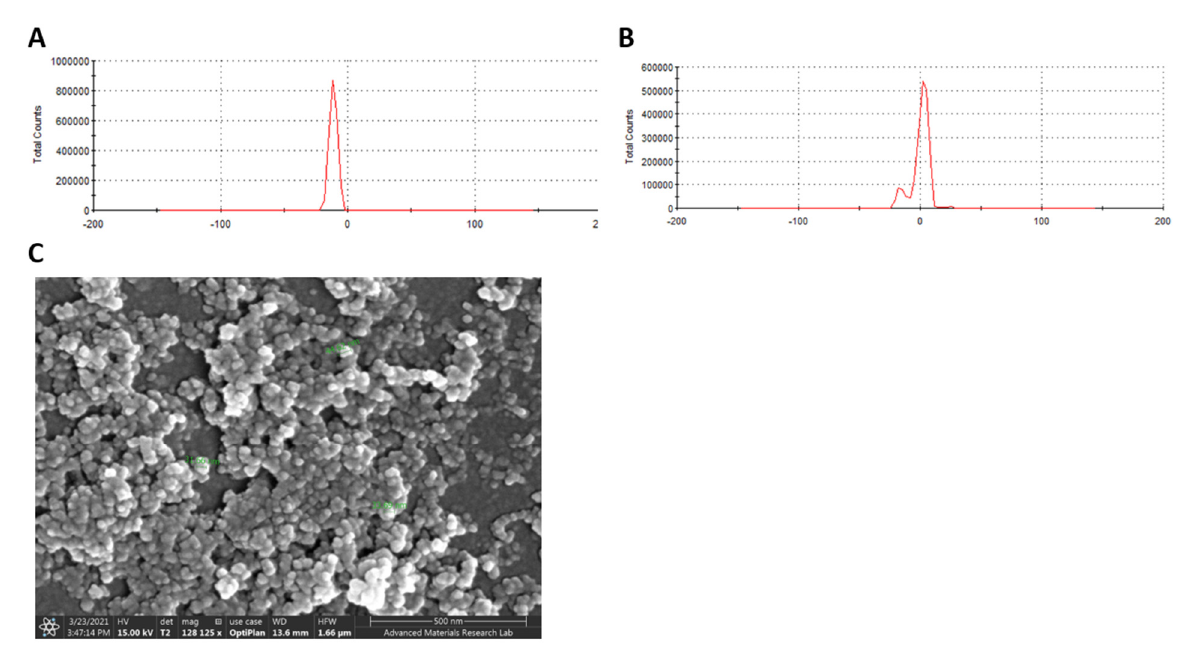
Figure 17. Characterization of compound-loaded ZnO NPs. Zeta potential measurement for ( A ) drug-free ZnO NPs and ( B ) ZnO NPs loaded with compound M3 . NPs samples were diluted with distilled water and zeta potential were determined using Laser Doppler Velocimetry (LDV) mode. ( C ) SEM micrographs of ZnO NPs loaded with M3 . ZnO NPs samples were placed on carbon tape after dryness then coated with gold prior to measurement.